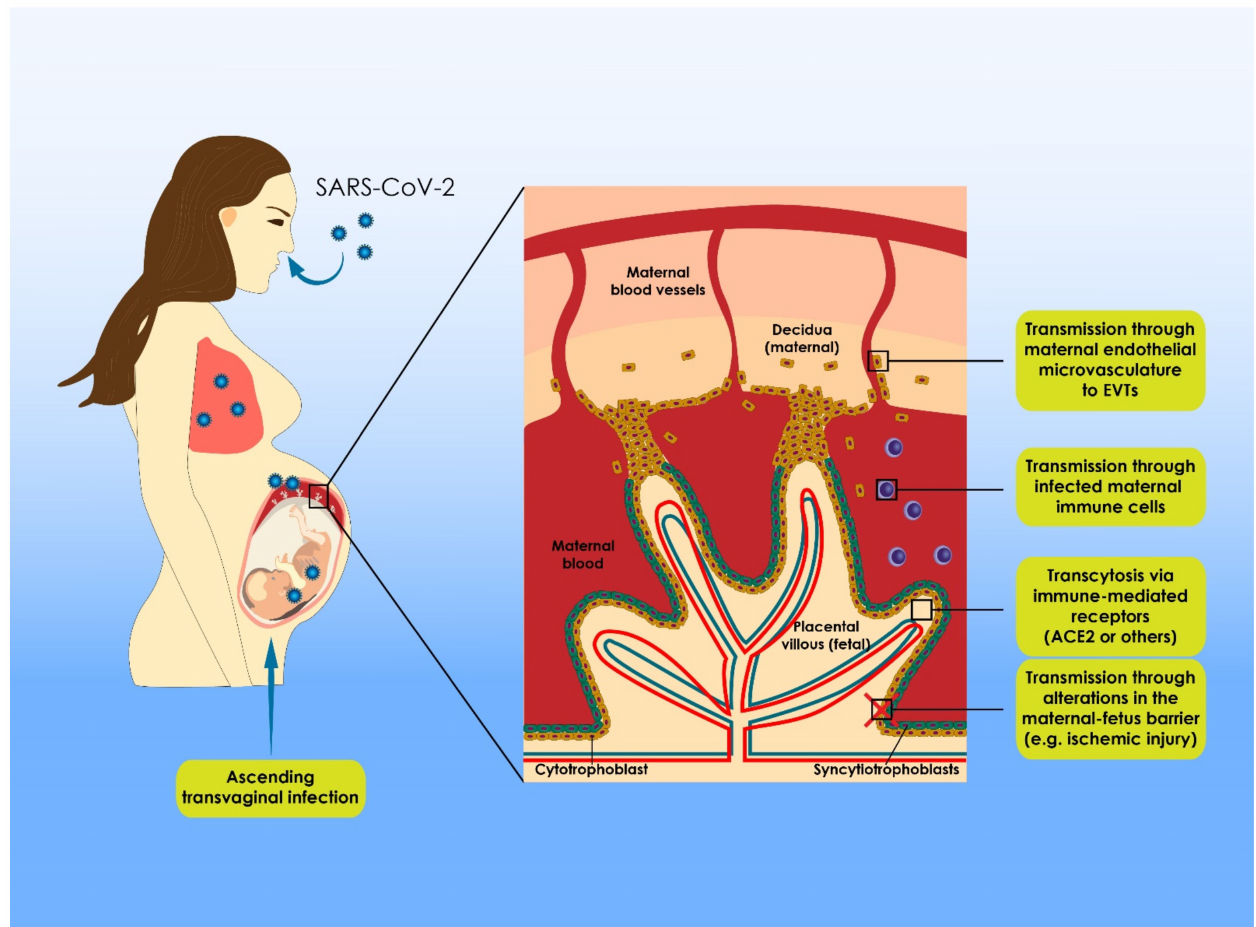
Figure 1. Suggested pathways for SARS-CoV-2 transmission from infected mothers to fetuses during pregnancy. Limited data are available regarding the role of placenta in SARS-CoV-2 infection, and thus the mechanisms of possible vertical transmission are still poorly understood. Considering the current knowledge, five possible infection routes have been proposed. Following infection of the mother, SARS-CoV-2 virions spread throughout the body via maternal circulation, finally reaching the maternal–fetal interface. According to the first suggested mechanism, transmission of SARS-CoV-2 could be achieved through maternal endothelial microvasculature to extravillous trophoblasts (EVTs) and other placenta cells expressing angiotensin converting enzyme 2 (ACE2) receptors. According to the second mechanism, SARS-CoV-2 virions could stimulate immune response in the maternal–fetal interface, inducing accumulation of maternal immune cells in the infected area, such as macrophages. Maternal immune cells could then be infected, as these cells express ACE2 receptors. Following this, the infected maternal immune cells could infiltrate the placenta and transmit the virus to the fetal cells (cell-to-cell transmission). The third proposed mechanism involves possible alterations in the maternal–fetal barrier, including ischemic injury and increased release of inflammatory regulators. These alterations lead to increased SARS-CoV-2 virions’ permeability throughout the placenta, leading finally to virions spreading in the fetal environment. According to the fourth proposed mechanism, both syncytiotrophoblasts and their rupture could directly be infected by virion transcytosis, mediated via immune receptors, including ACE2 and Fc (FcR). Finally, fetal infection originating from ascending vaginal infection has also been